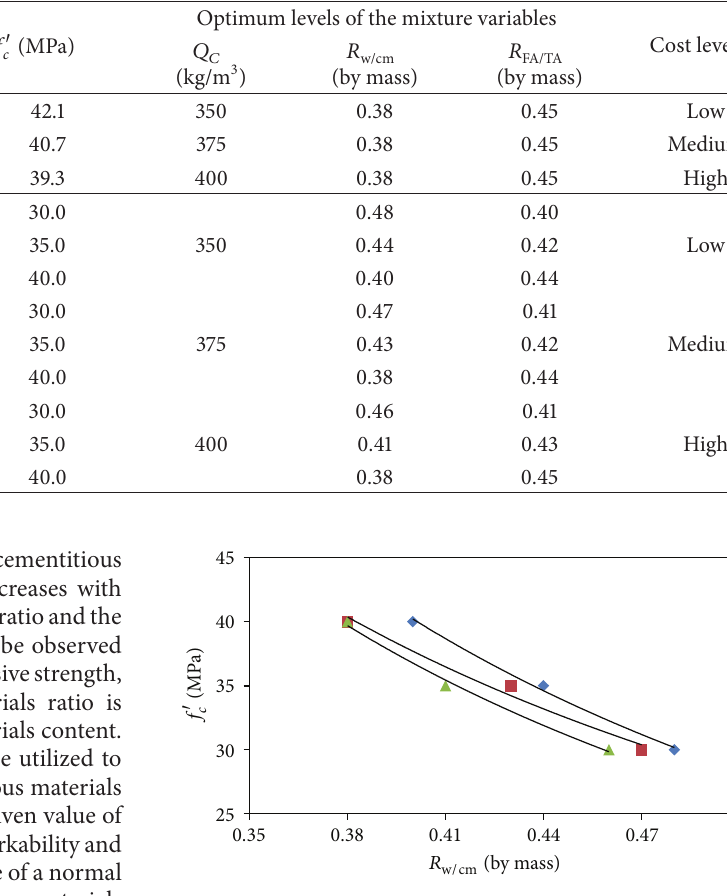
Table 6: Optimization of concrete mixture design.